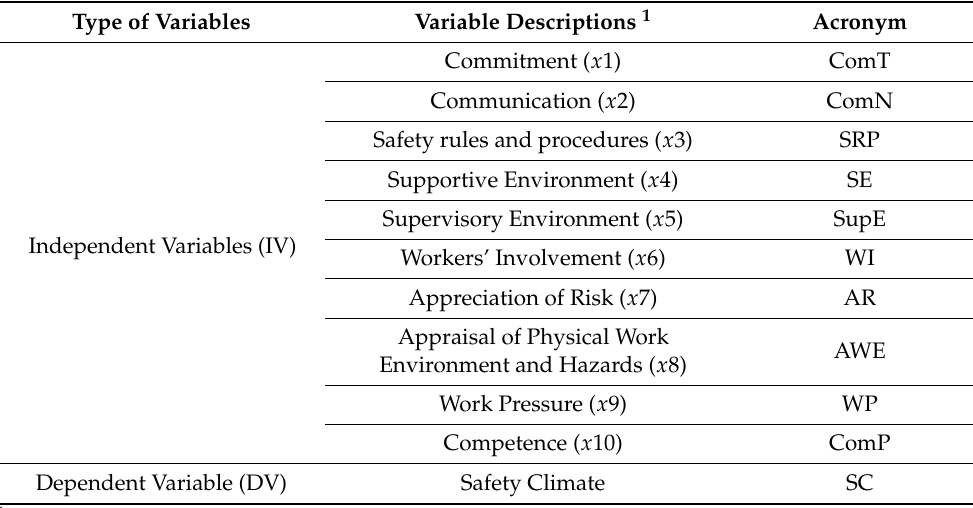
Table 1. Description of Variables (Applied from Mohamed, 2002 [8]).